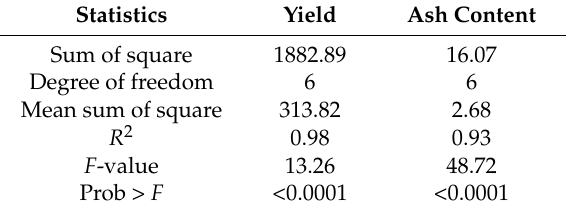
Table A1. Statistical significance of the whole model for yield and ash content of the concentrate.